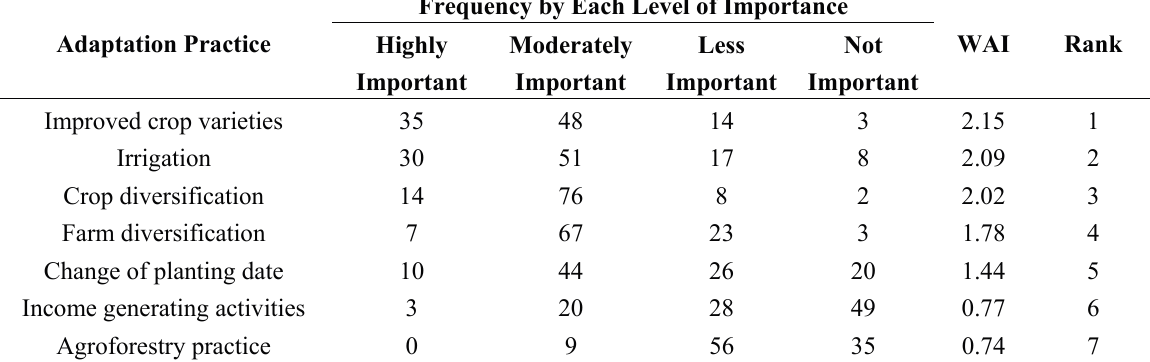
Table 4. Farmers’ ranking of adaptation practices in the Lawra district of Ghana (Number of respondents = 100) .